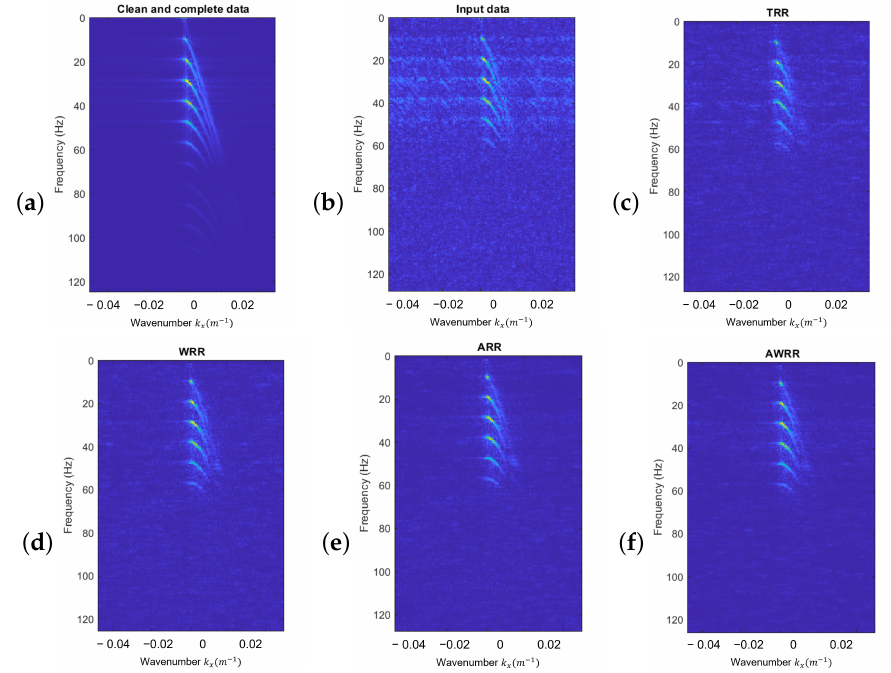
Figure 12. f − k spectral comparison of ( a ) clean and complete data, ( b ) input data, ( c ) TRR result, ( d ) WRR result, ( e ) ARR result, ( f ) AWRR result.